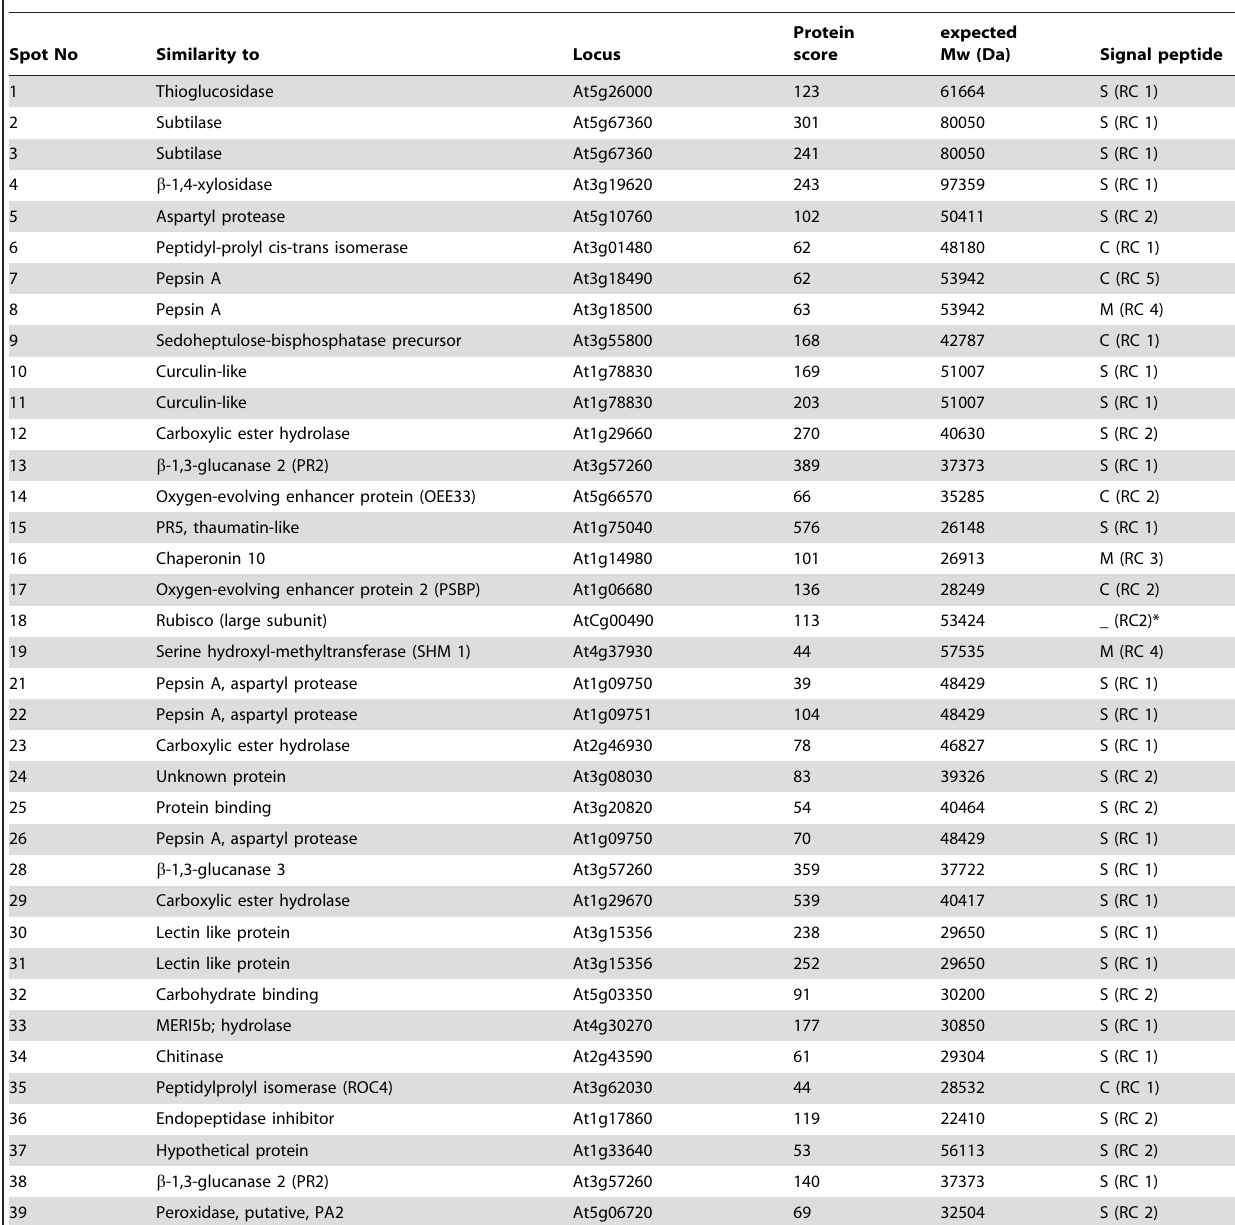
Table 4. Proteins identified by LC-MS/MS in the apoplast of Arabidopsis thaliana